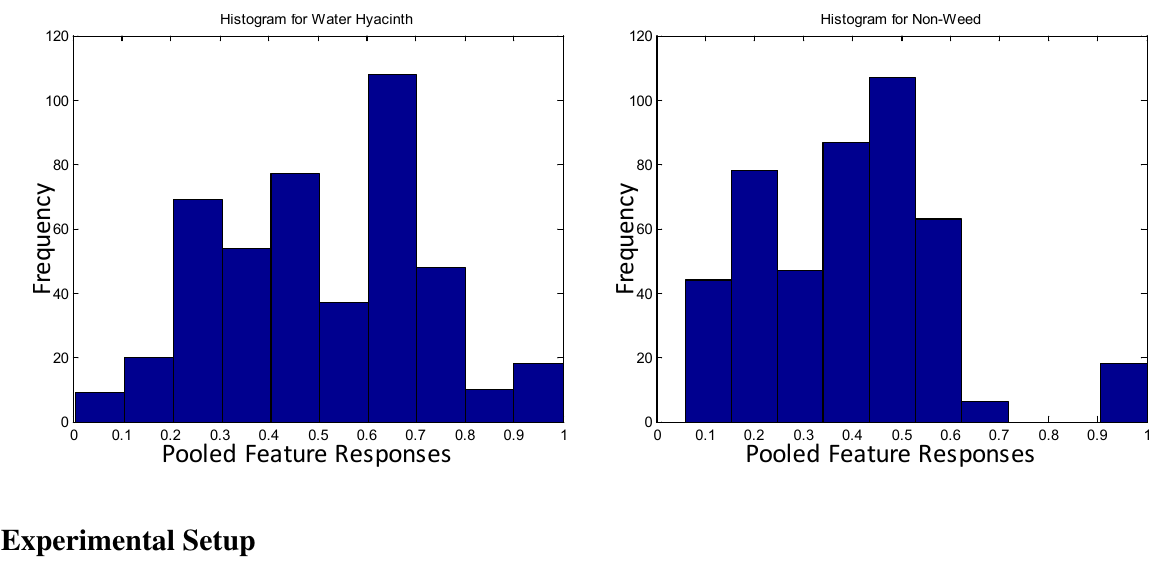
Figure 5. The histogram of the texton representing the water hyacinth and non-weed class. The histograms are visually distinct, indicating that the classes are easily